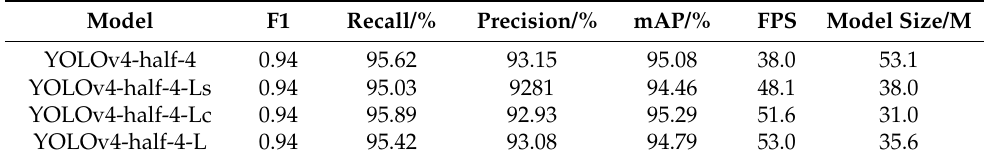
Table 3. Comparison table of neck network shear comparison experiment.